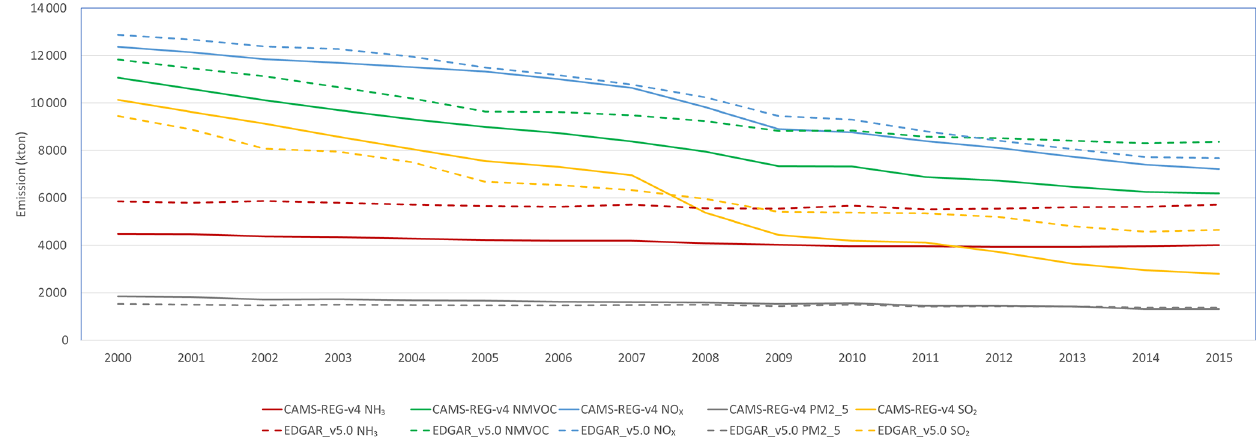
Figure 11. Trends in CAMS-REG-v4.2 (solid lines) and EDGAR-v5.0 (dashed lines) for five key pollutants between 2000–2015 (Russian Federation is excluded from the comparison). Table 5. GNFR categories and their estimated uncertainty based on the default approach to emission inventories using activity data and emission factors and the typical source of the data. Adapted from EEA (2019a). SO 2 NO x NMVOCs CO NH 3